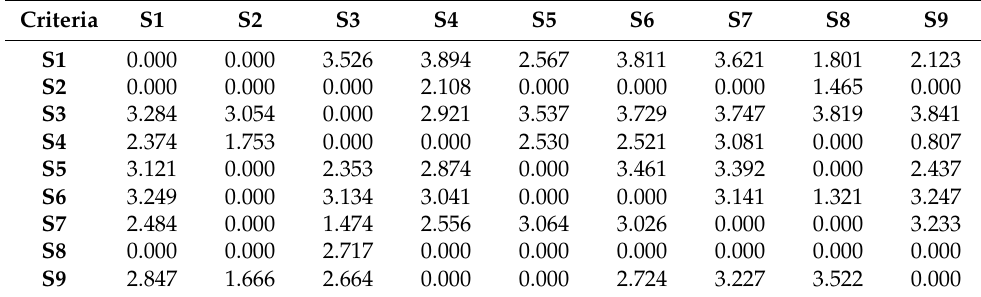
Table 2. The initial direct-relations matrix.